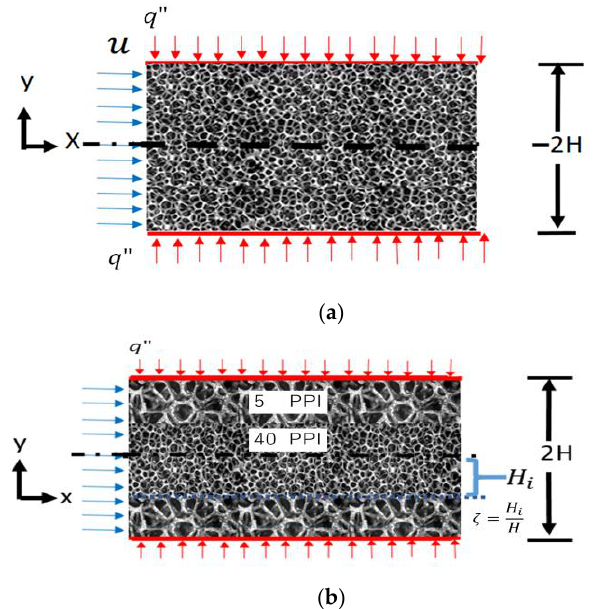
Figure 1. Schematic demonstration of the considered problems, ( a ) channel with uniform aluminum foam, ( b ) channel with two-layer aluminum